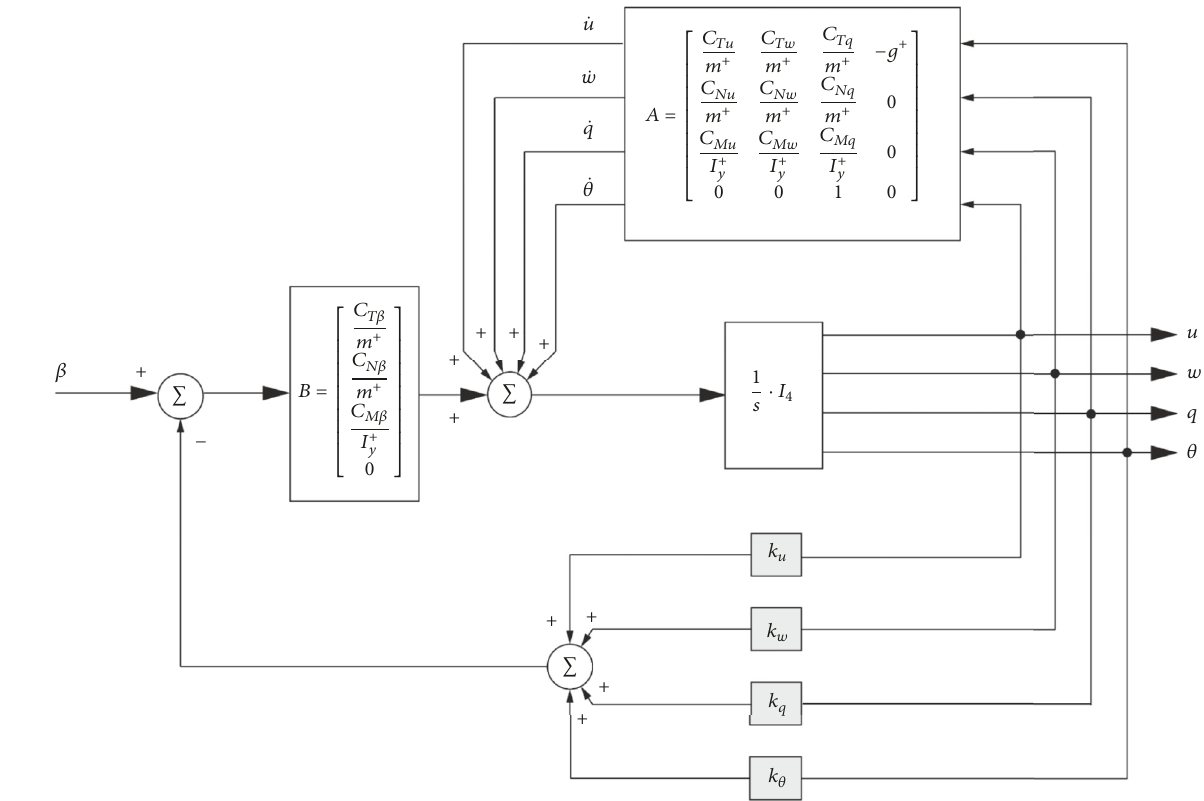
Figure 3: Scheme of state feedback control